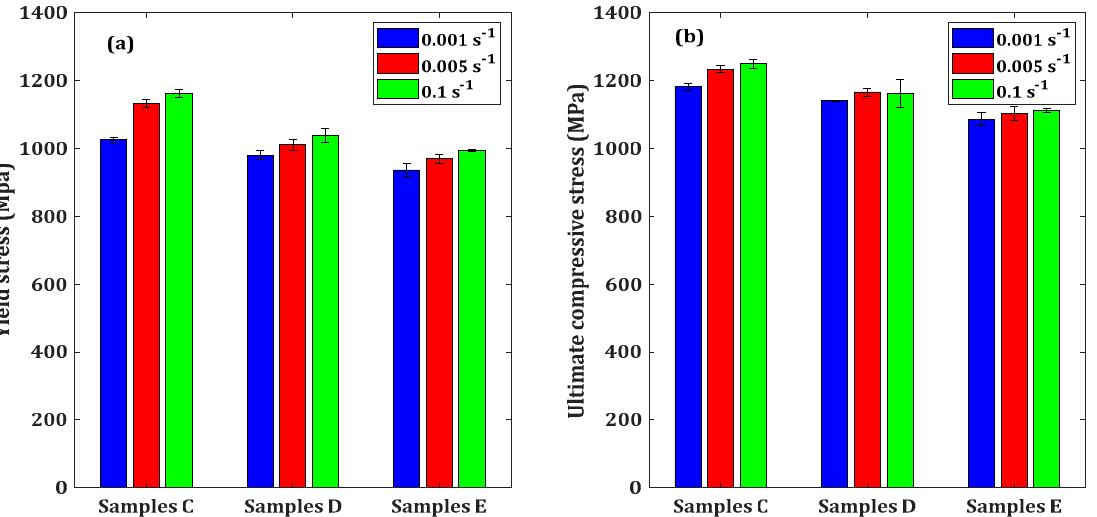
Figure 11. The stress–strain curves of samples ( a ) C, ( b ) D and ( c ) E at various strain rates, while ( d ), ( e ) and ( f ) show the comparison of the flow stress curves of these different samples at strain rates of 0.1 s − 1 , 0.005 s − 1 and 0.001 s − 1 , respectively.